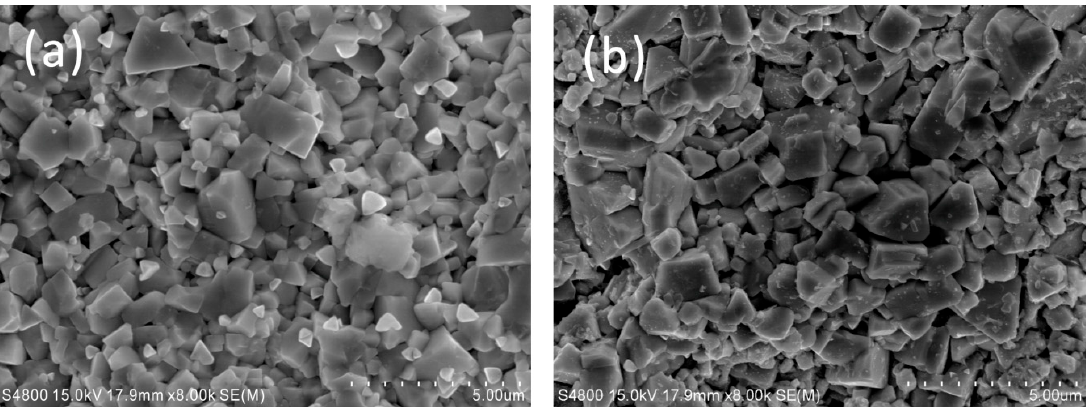
Figure 3. Microstructures of samples fractured faces: ( a ) S0; ( b ) S3.